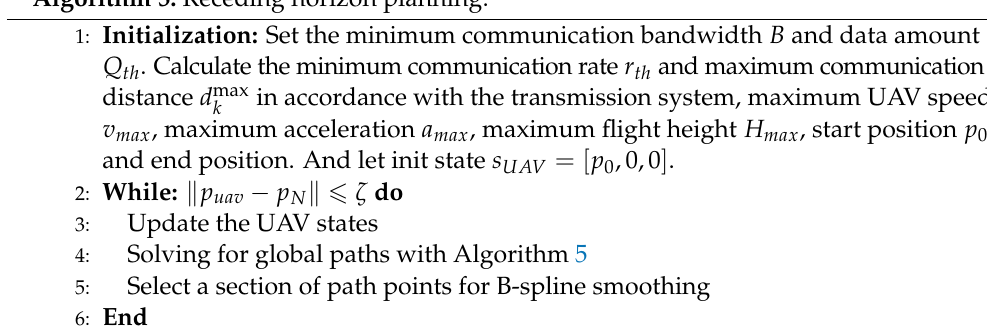
Algorithm 5: Receding horizon